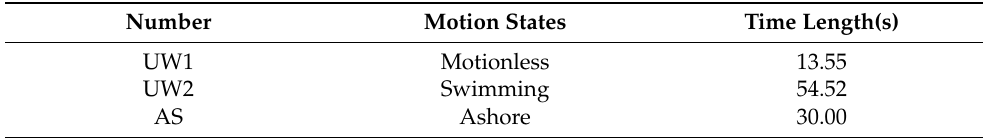
Table 2. Preprocessed EEG signals of various states.